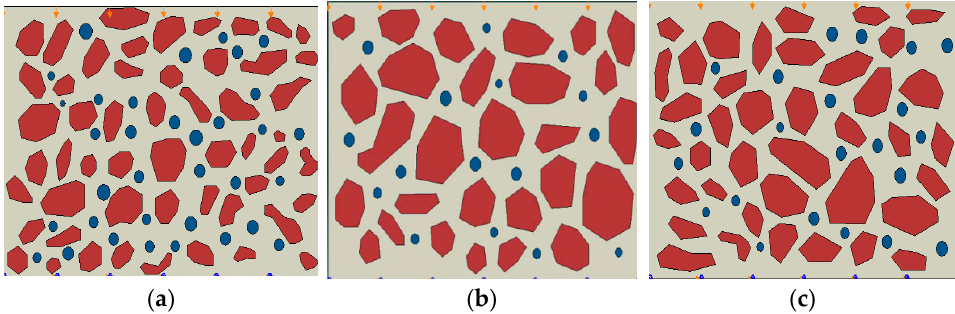
Figure 5. Relationship between pore stress and water content.